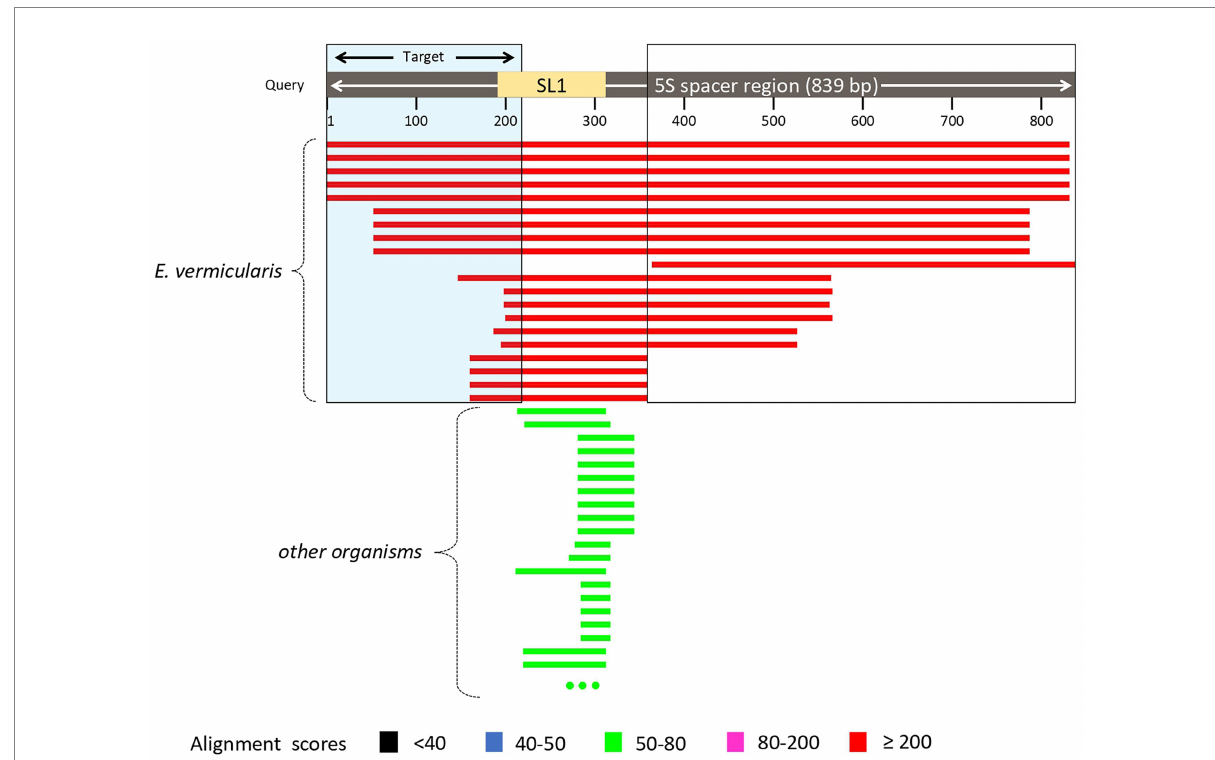
FIGURE 3 Analysis of Enterobius vermicularis SL1 of the 5S spacer region using the Nucleotide Blast tool. The records with the highest alignment score with the query sequence (bars in red) corresponded to different E. vermicularis isolates, while those with the lower alignment score (in green), correspond to other organisms. The two segments at both the ends are highly specific for E. vermicularis . The first tract corresponds to nucleotides 1–223 (223 bp) and the second one to nucleotides 341–839 (499 bp) of the 5S spacer